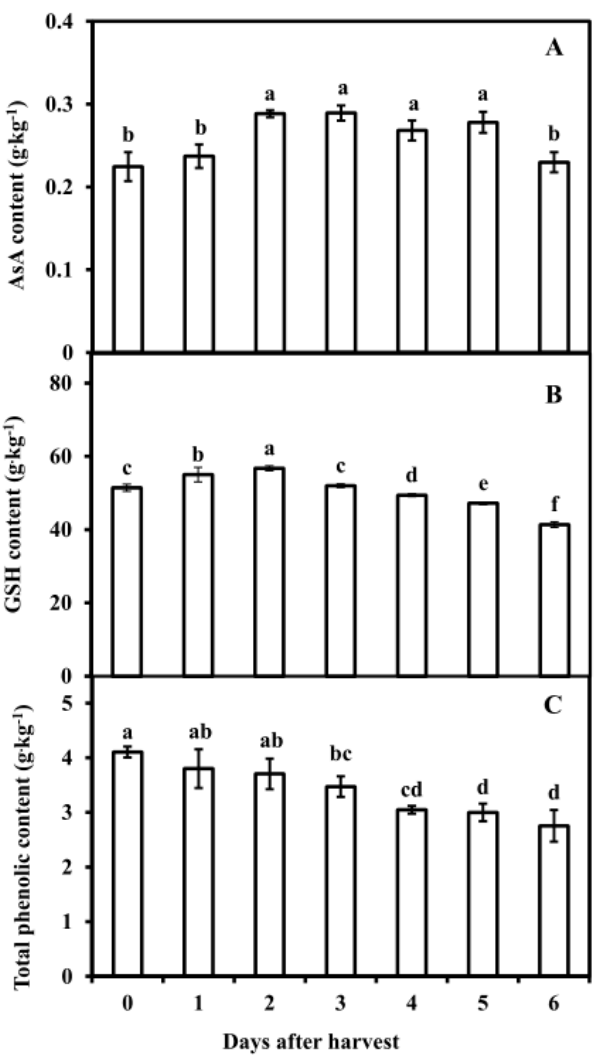
Figure 4. Content of the antioxidant substrates of pericarp of fruit stored at room temperature (25±2 °C) for 0 to 6 d. ( A ), AsA content; ( B ), GSH content; ( C ), Total phenolics content. Vertical lines represented the standard deviation of the means of three replicates. Different small letters indicated significant difference at p < 0.05.